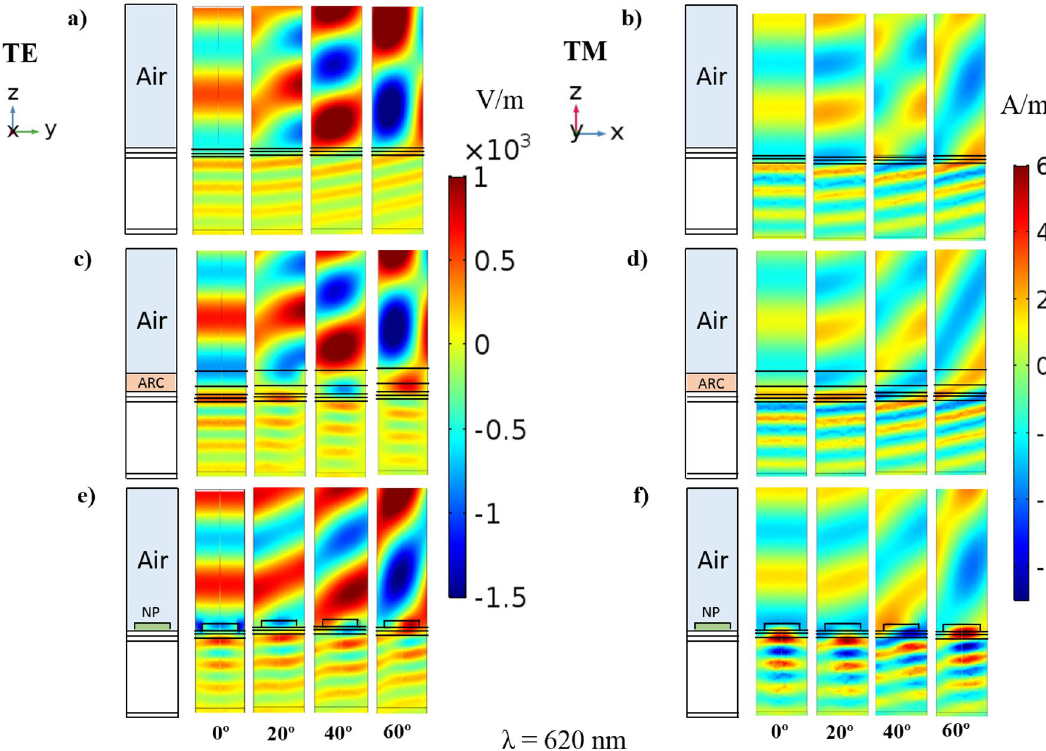
Figure 4. Spatial distribution of the electric and magnetic field intensities in the solar cell. ( a ) Electric field and ( b ) magnetic field distribution in a conventional solar cell. ( c ) Electric field and ( d ) magnetic field distribution in a GaAs solar cell including an ARC. ( e ) Electric field and ( f ) magnetic field distribution in a GaAs solar cell including AlAs nanoparticles on it. All the cases consider four different angular incidences, from left to right: normal (0°), 20°, 40° and 60°. The images show a unit cell of the device (w = 350 nm) with an air layer (1 μm) on top of it. Only the space (SiO 2 , 25 nm), window (InGaP, 30 nm) and GaAs (500 nm) layers are shown in